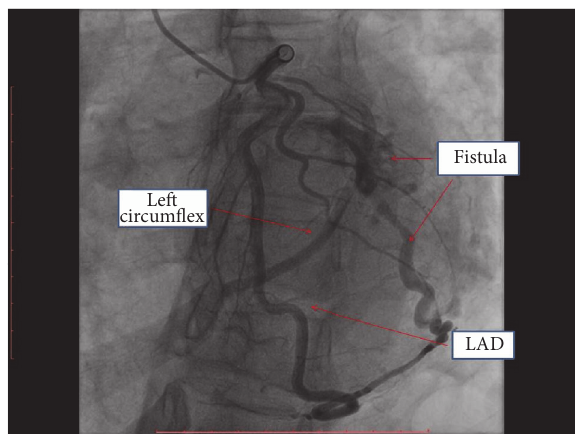
Figure 1: Coronary angiogram showing a fistula connecting distal left anterior descending artery (LAD) and first obtuse marginal artery (OM1) to the left ventricular cavity.